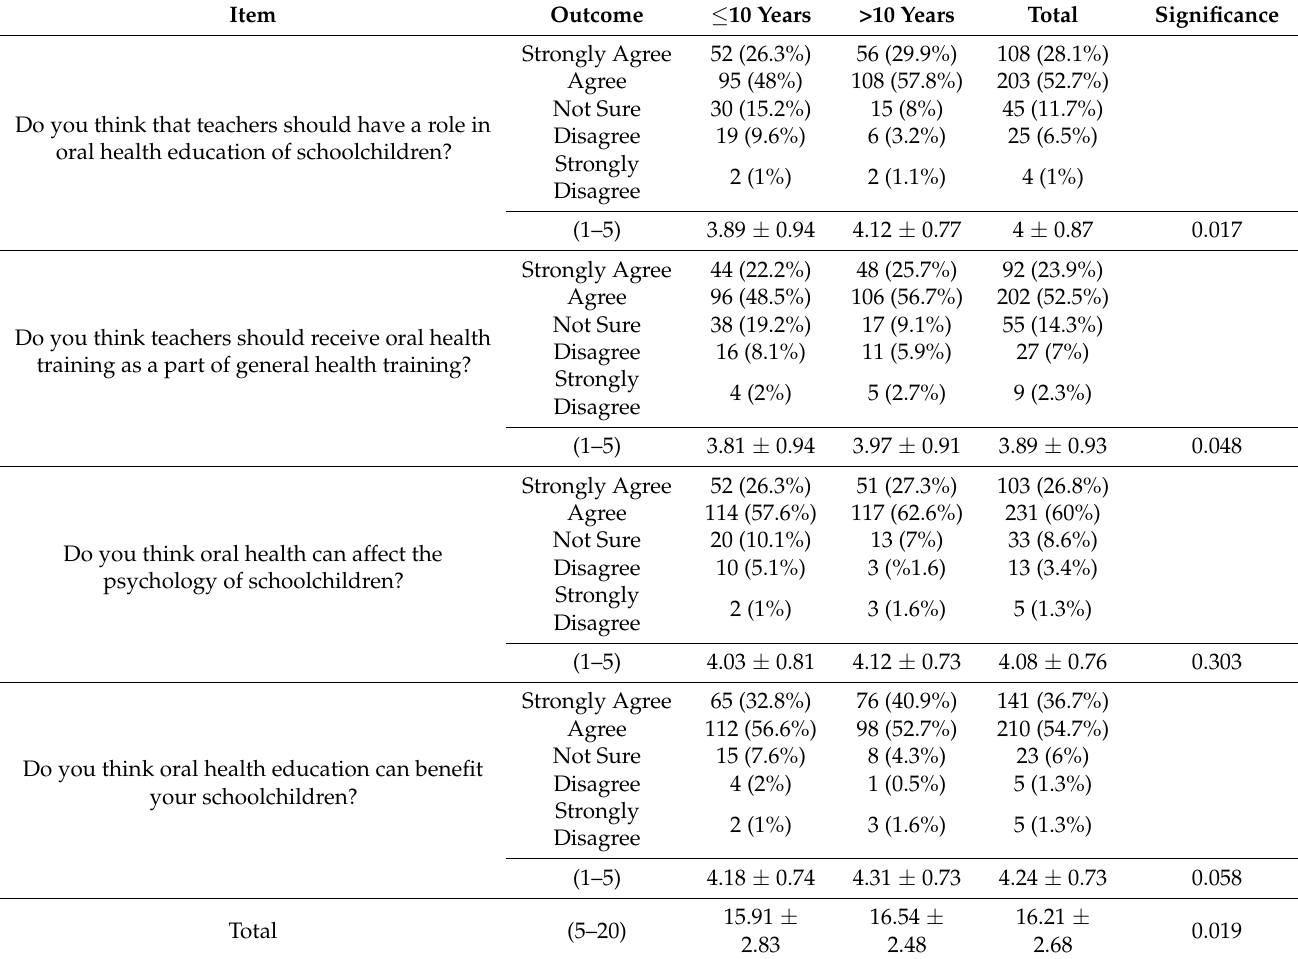
Table 4. Oral health-related attitudes of elementary schoolteachers stratified by work